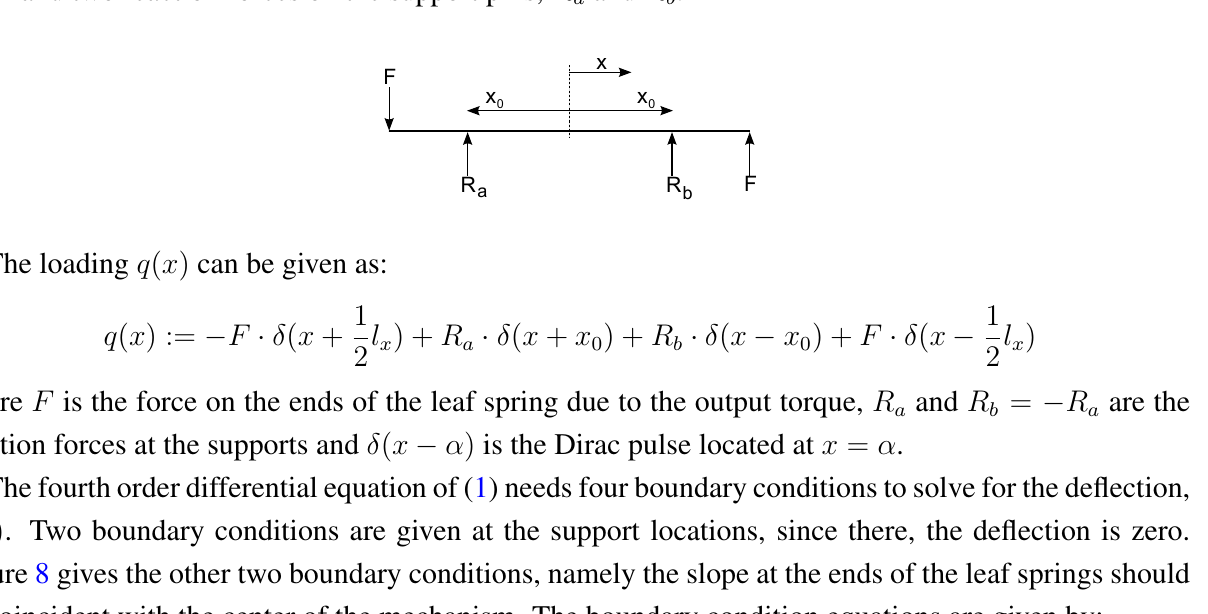
Figure 7. Force profile on the leaf spring, consisting of four forces: two applied forces, F , and two reaction forces on the support pins, R